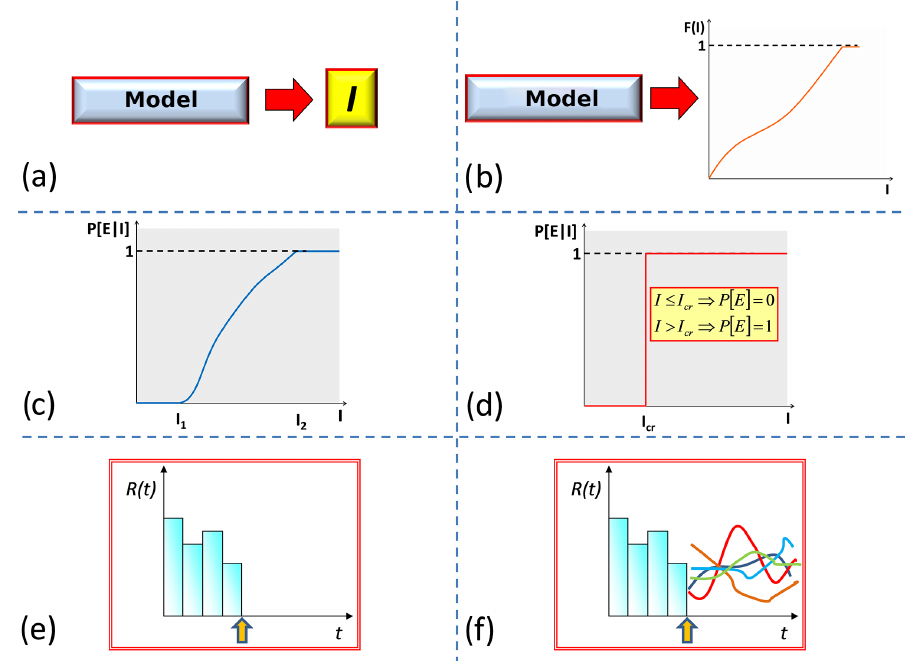
Figure 1. Several aspects characterizing a scheme for rainfall thresholds. Definition of I : (a) deterministic value; (b) probability distribution F(I) . Modelling of P [ E | I ] : (c) generic monotonic non-decreasing function; (d) step function. Use of rainfall input: (e) only data observed in real time; (f) also prediction from meteorological and/or stochastic